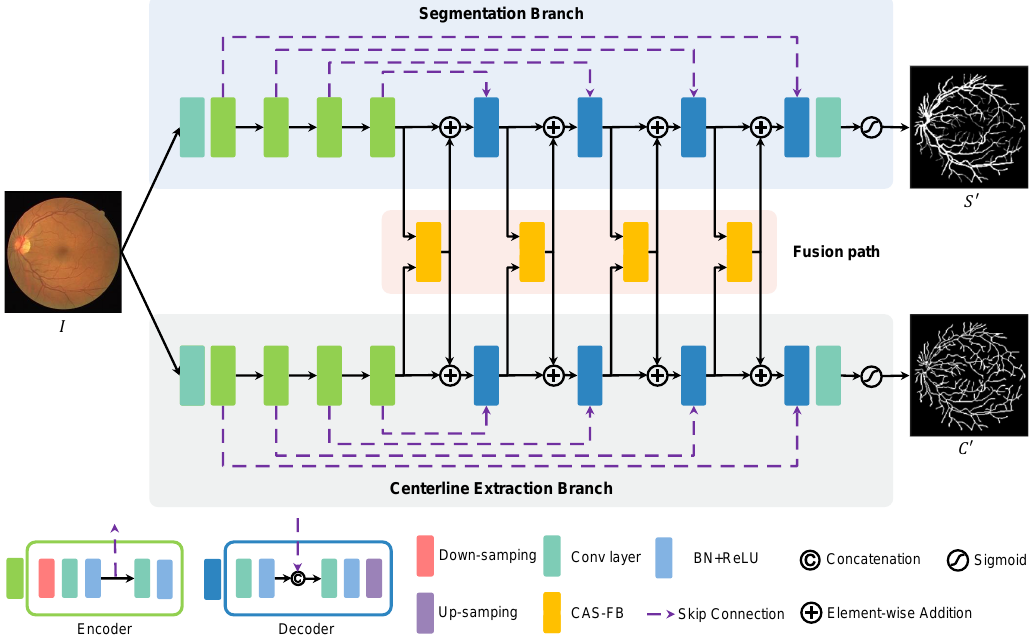
Figure 2. The network architecture of MSC-Net consists of a blood vessel segmentation branch, a centerline extraction branch, and a fusion path. The fusion path aggregates the features of the two branches to effectively correct and supplement the features of the two